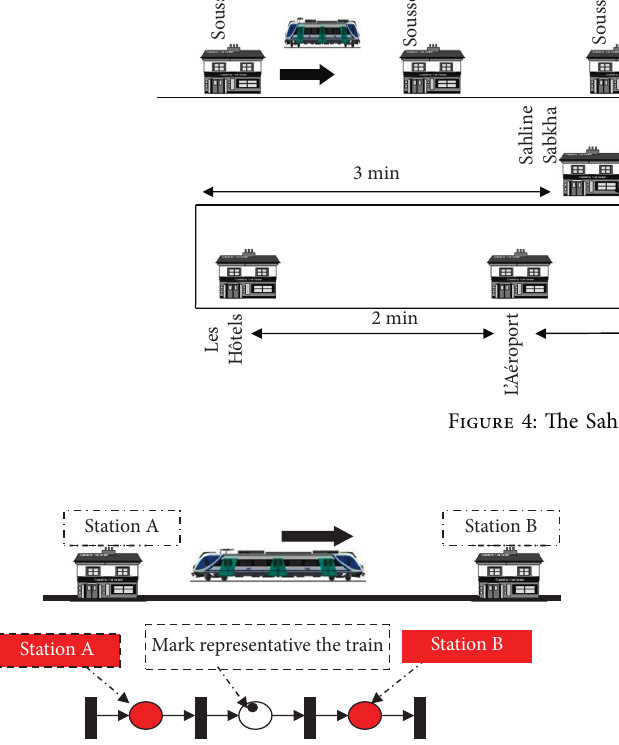
Figure 5: Single directional segment